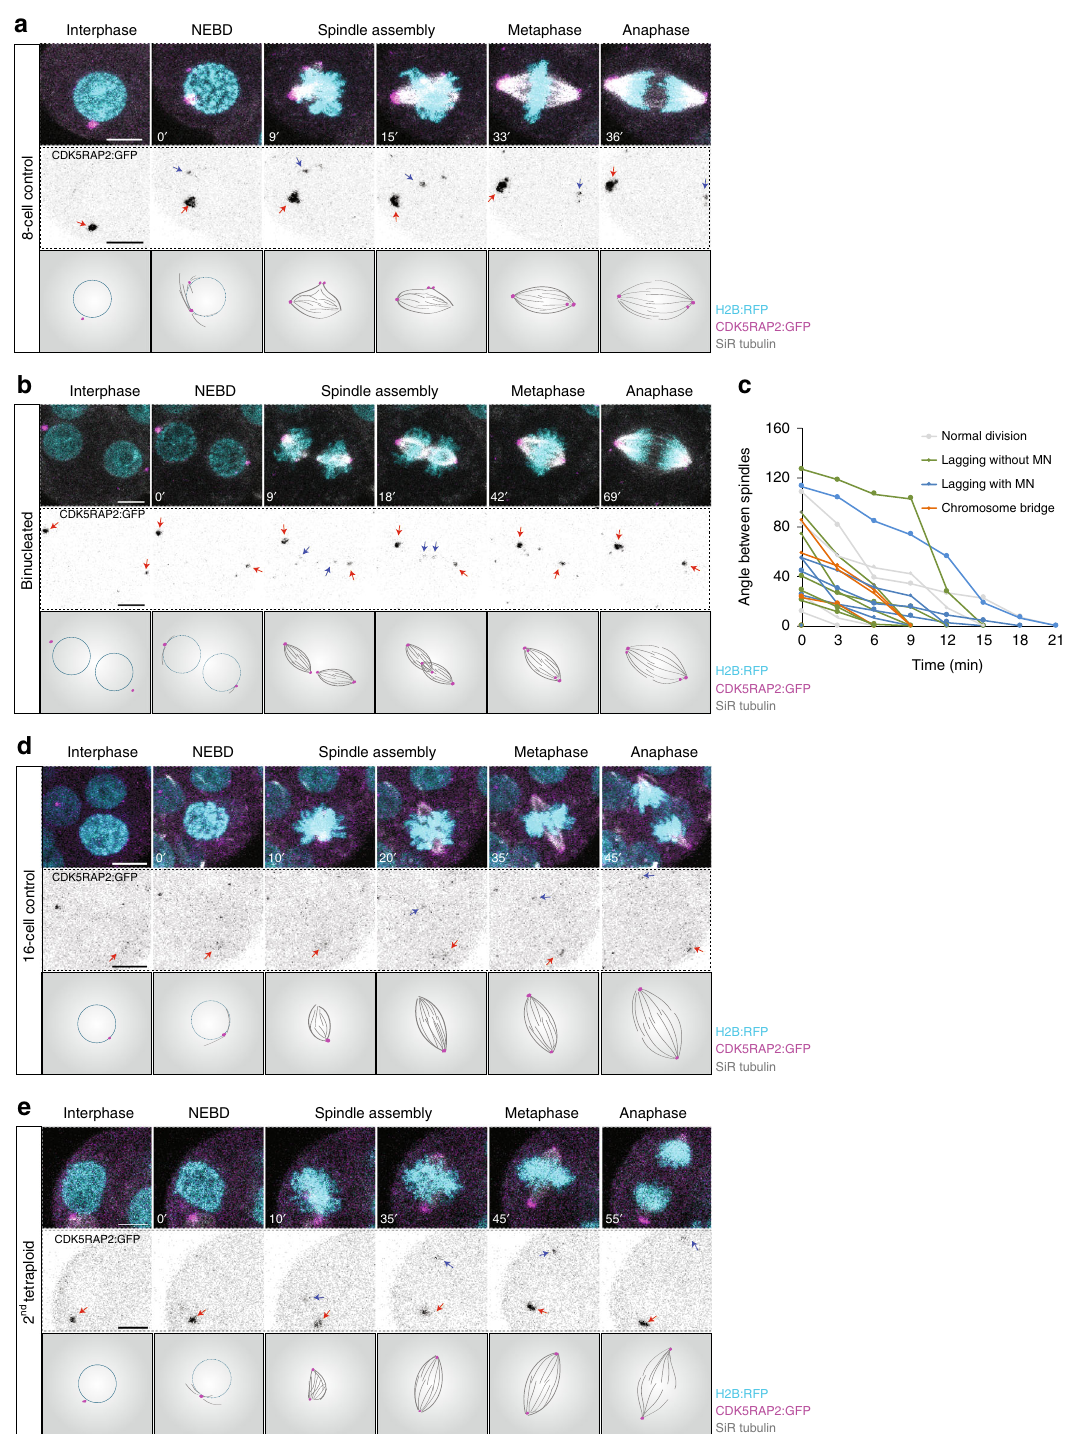
Fig. 2 Chromosomal instability in tetraploid embryos is not attributable to supernumerary centrosomes. a , b , d and e Representative time-lapse images and illustrations of live 8-cell control ( a ), 4-cell binucleated ( b ), 16-cell control ( d ) and 8-cell tetraploid embryos ( e ) labelled with SiR Tubulin (grey) and co- expressing H2B:RFP (cyan) and CDK5RAP2:GFP (magenta and inverted grey). A major microtubule organising centre (MTOC) can be observed in the 8- cell control, 16-cell control and 8-cell tetraploid embryo during interphase (red arrows) and a newly assembled MTOC can be observed during mitosis (blue arrows). In binucleated embryos, two major MTOCs (red arrows) can be observed during interphase and two newly assembled MTOCs (blue arrows) can be observed during mitosis. c Measurements of the angle between the two individualised spindles during the binucleated division. Line colours represent the different types of chromosome segregation events associated with a speci fi c cell division ( n = 23 divisions from 12 embryos). Chromosome segregation errors observed included: lagging chromosomes resulting in micronuclei formation (lagging with MN); lagging chromosomes that did not result in micronuclei formation (lagging without MN); and chromosome bridges. Scale bars = 10 µ m. NEBD nuclear envelope